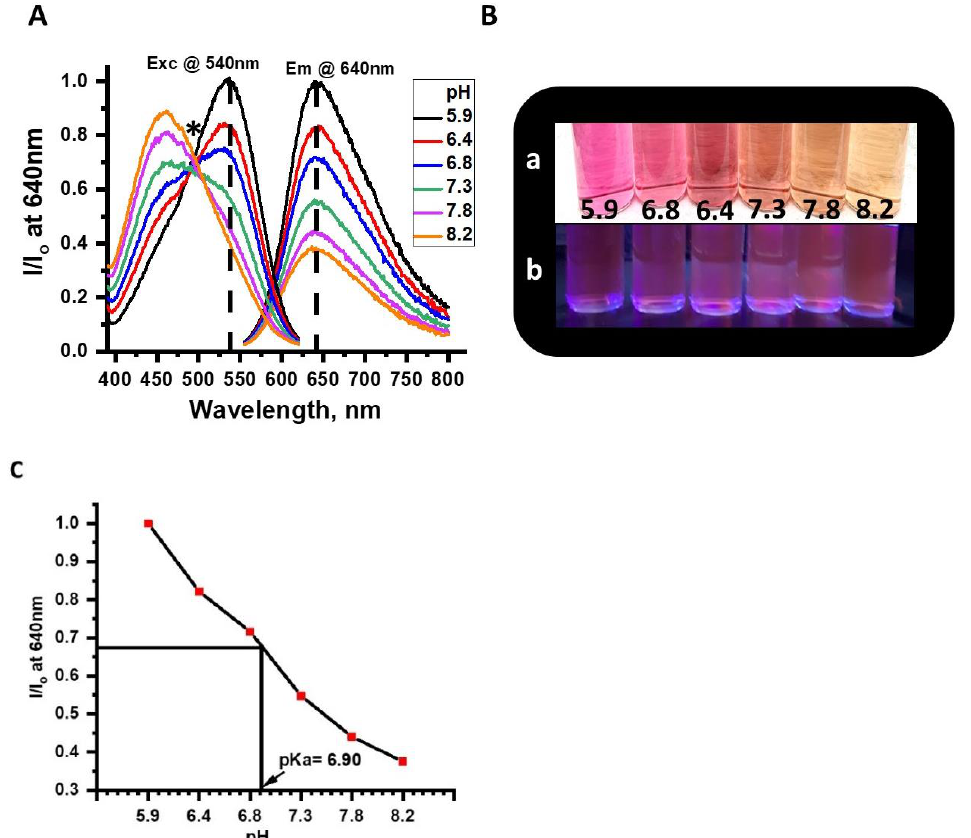
Figure 4. Changes in fluorescence of NR solution at different pH, ( A ) Excitation and emission spectra of NR buffer solutions recorded at 640 nm and 540 nm excitation wavelengths at pH values ranging from 5.9 to 8.2. The ‘*’represents the isosbestic point at around 470 nm. ( B ) Changes in physical and emission color of the complex with the respective pH of the NR buffer solutions, ( a ) Under ambient light, and ( b ) Under UV irradiation. ( C ) Emission intensity changes vs. pH at 640 nm wavelength for the same solutions. The arrow points at the pKa of the NR solution.